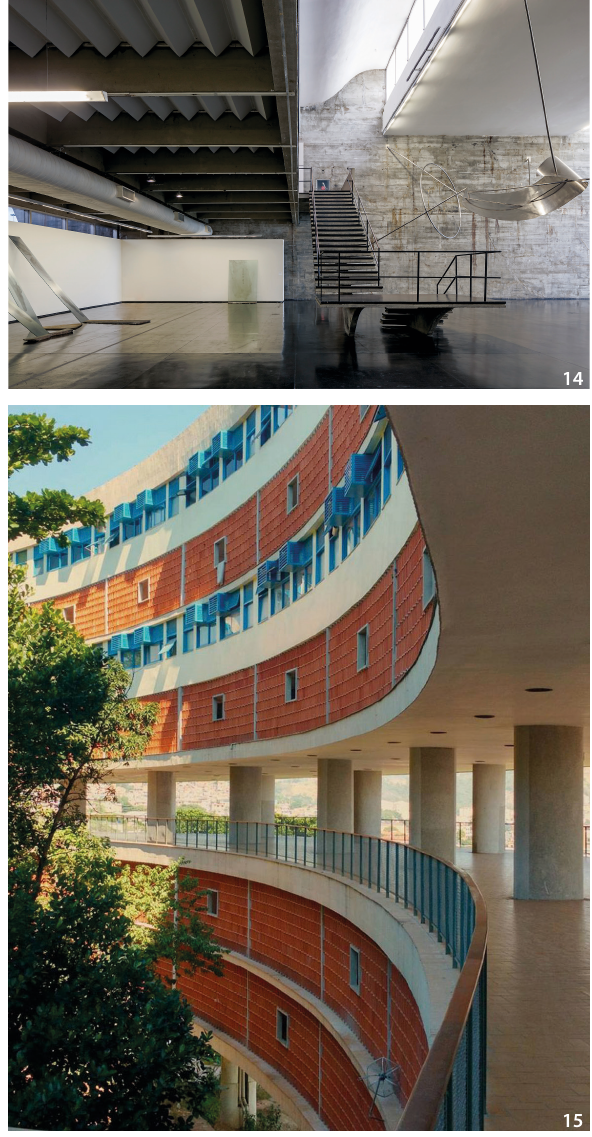
Figure 14 Affonso Eduardo Reidy, Museum of Modern Art, second floor with ducts (Source: Leonardo Finotti). Figure 15 Affonso Eduardo Reidy, Pedregulho Social Interest Housing, individual AC units after restoration (Source: the